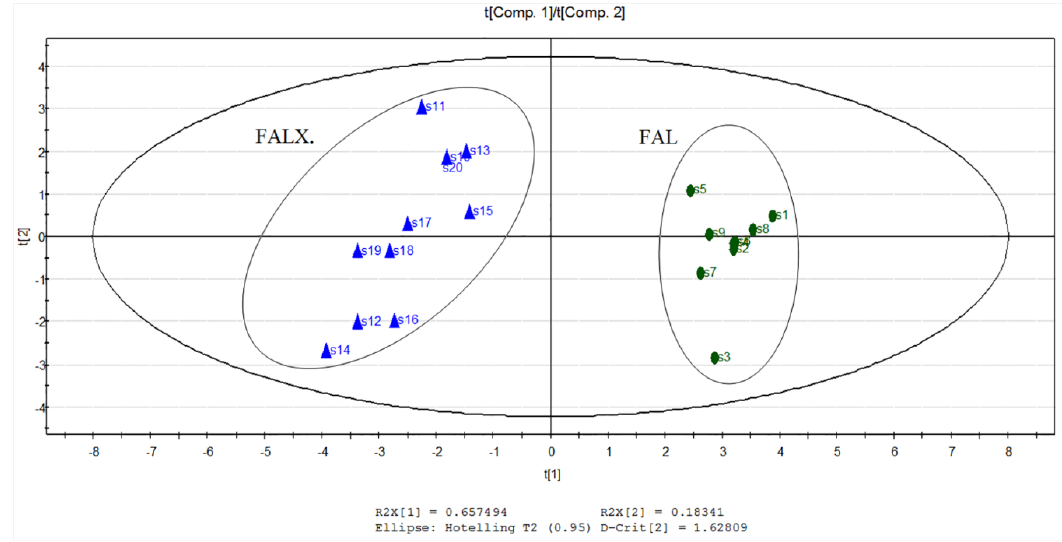
Figure 5. Score plot of principal component analysis of 20 samples of FA from two species.